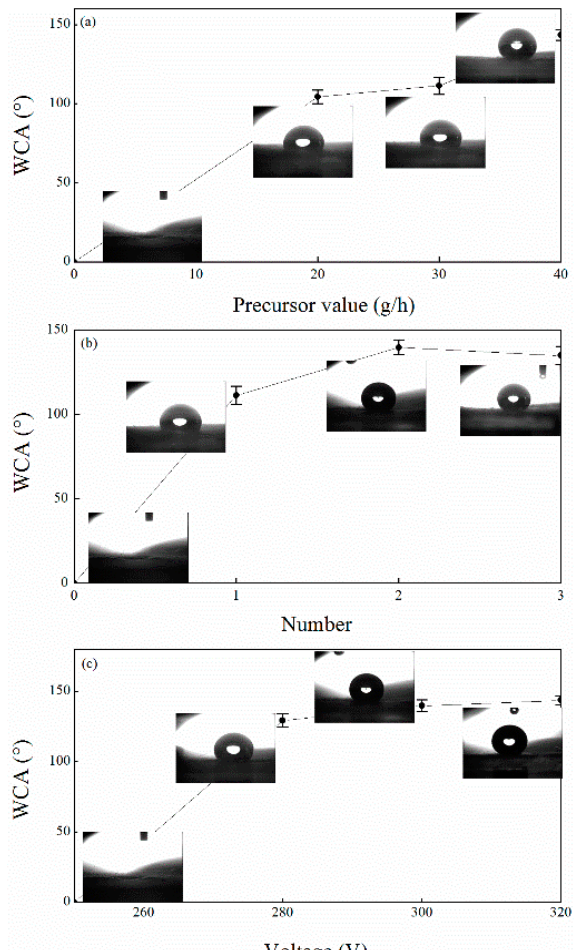
Figure 4. Relationship between the parameters in the plasma treatment process and the WCA under the following conditions: ( a ) voltage 300 V, one treatment, ( b )voltage 300 V, precursor value 30 g/h, and ( c ) precursor value 30 g/h, two treatments.